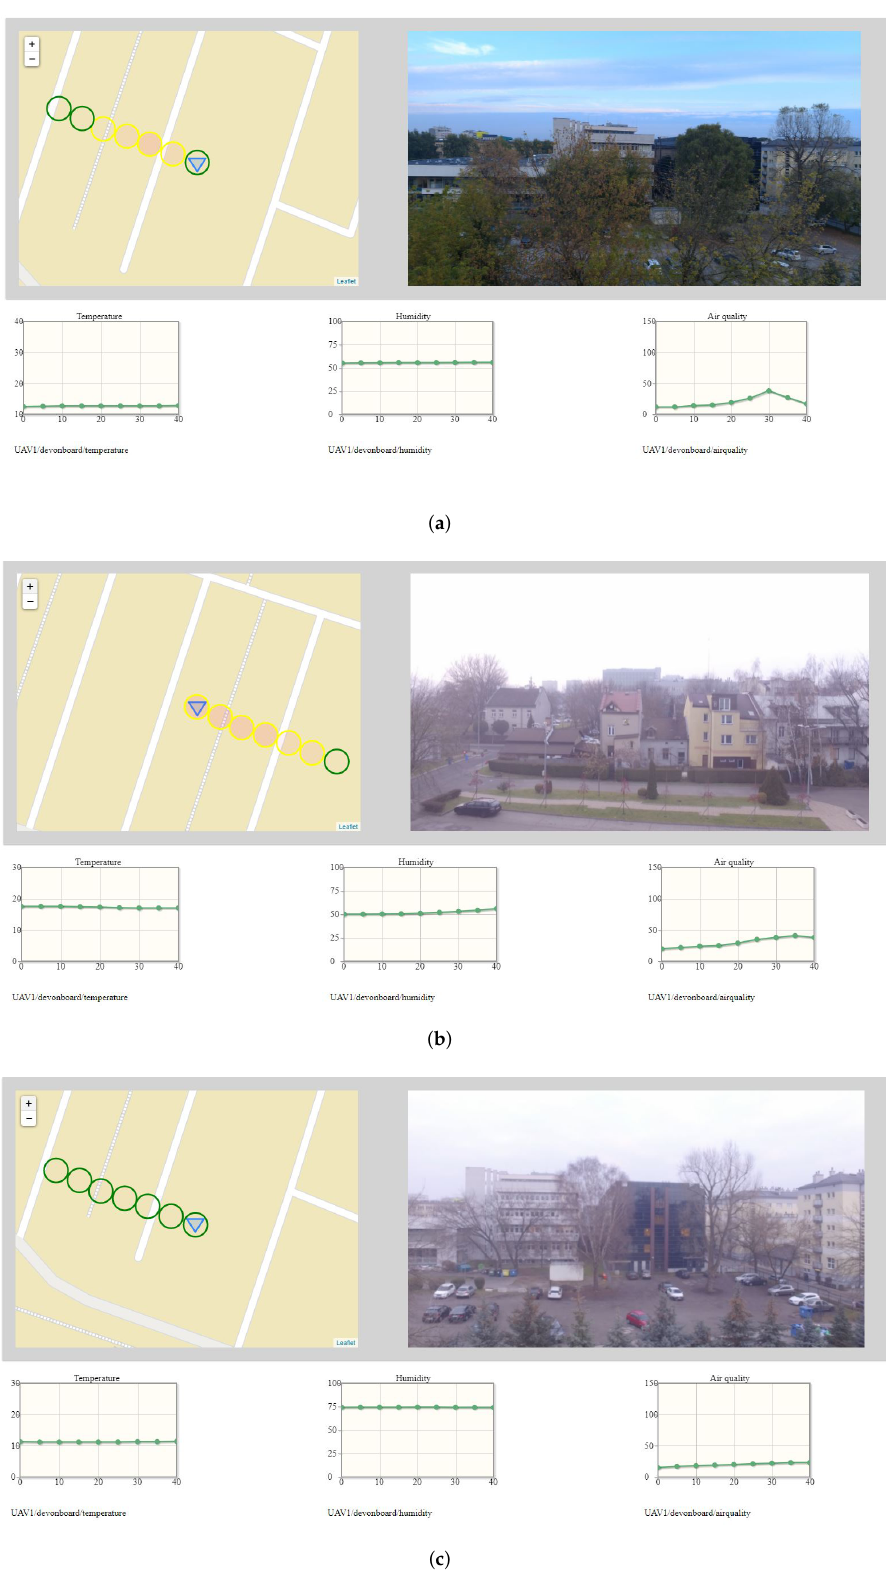
Figure 9. Typical situational contexts observed during Kestrel’s flights: ( a ) instantaneous worsening of air quality; ( b ) from good to worse air quality; ( c ) continuously good air